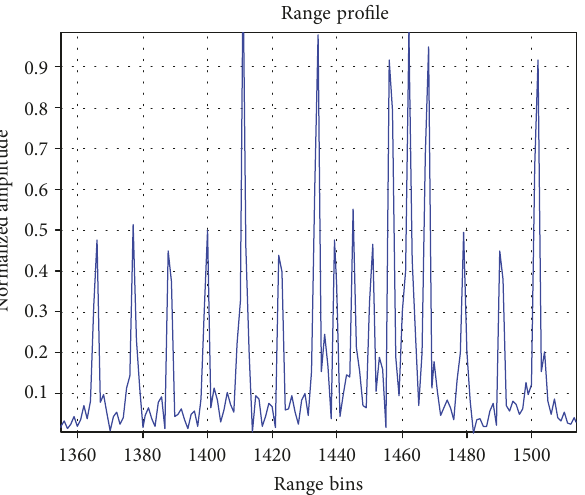
Figure 4: The output after speed